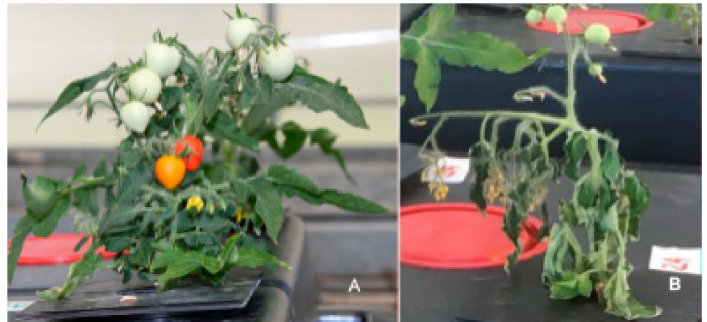
Figure 15. The representative features of the tomato plants (aerial parts) cultivated under water-stressed conditions coupled with root treatment with paramylon nanofibers ( A ) and under water-stressed conditions without paramylon nanofibers ( B ) 60 days after